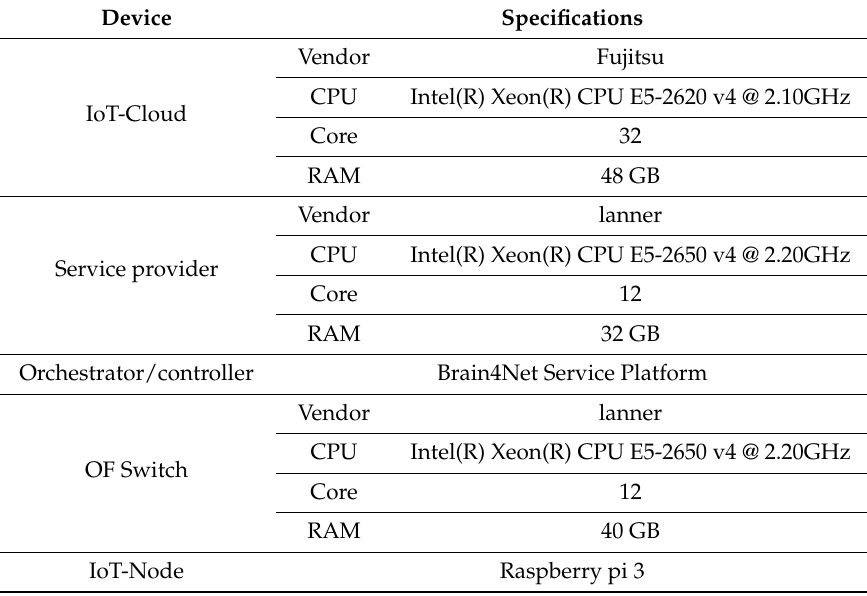
Table 1. The experimental parameters and device